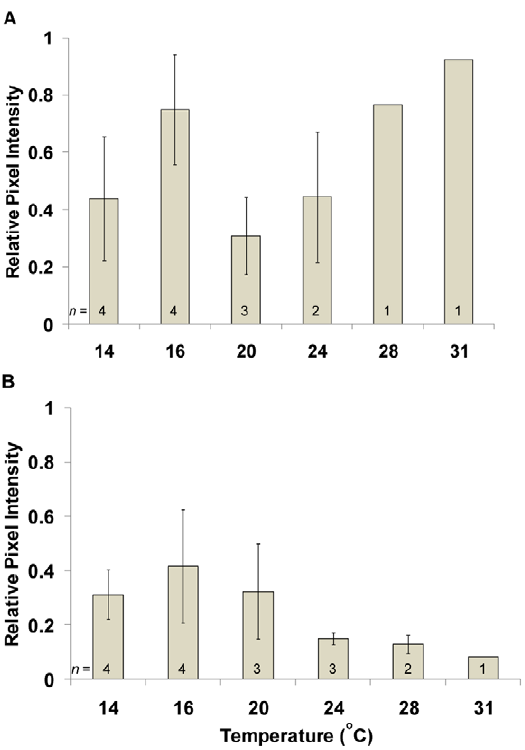
Figure 4. Level of heat-shock protein (Hsp70) in the invasive Diplosoma (A) and native Distaplia (B). Total Hsp70 (shown as mean [ 6 1 SE] immunoblot pixel intensity relative to an internal standard) in Diplosoma (A) and Distaplia (B) individuals after a 24 h exposure to 6 treatment temperatures and a 48 h recovery period at ambient temperature. Sample sizes are shown at the base of the columns.